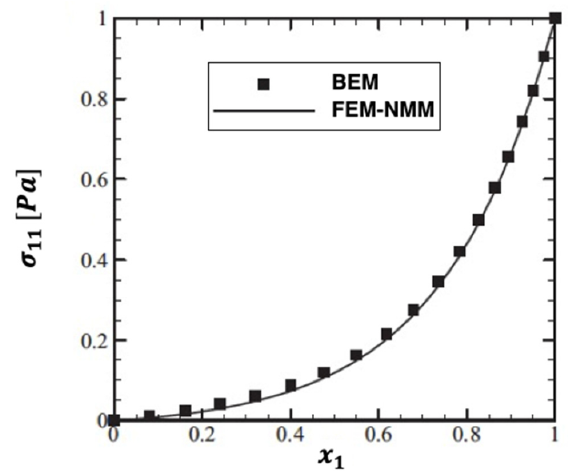
Figure 20. Variation of the thermal stress wave σ 11 along x 1 − axis in the special case of the functionally graded anisotropic fiber-reinforced plates for BEM and FEM-NMM.